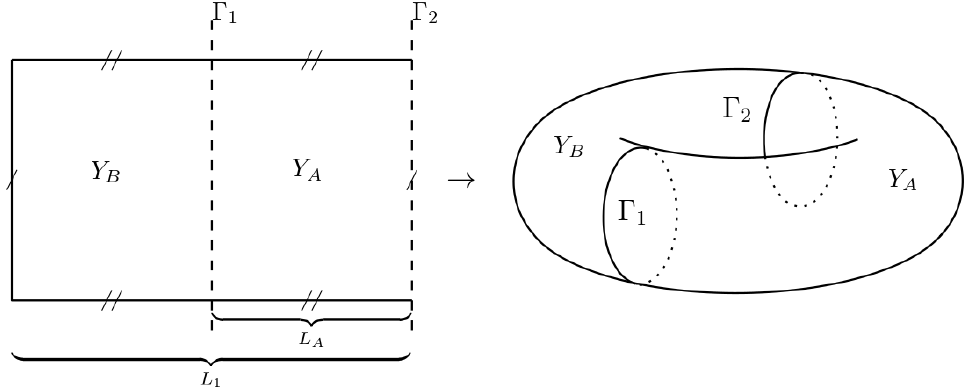
Figure 4 . The torus is cut into cylinders Y A and Y B by the two entangling cuts (cid:0) 1 and (cid:0) 2 . in (cid:12)gure 4. The replica method for the entanglement entropy on the torus was